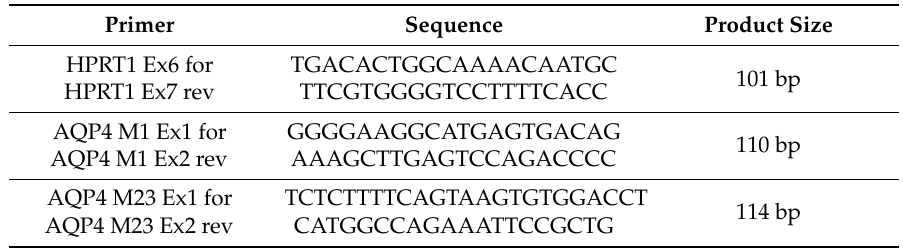
Table 3. Primer ( Homo sapiens ).